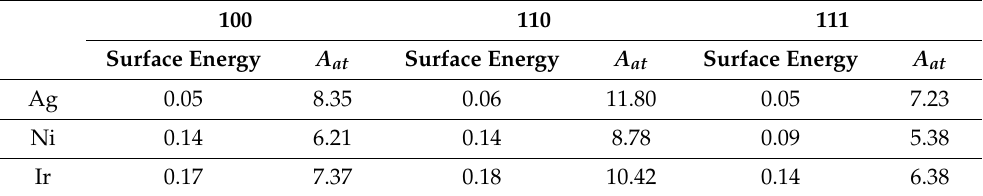
Table 1. The surface energies (eV/Å 2 ) and the surface area per atom A at (Å 2 ) of the three metals. 100 110 111 Surface Energy A at Surface Energy A at Surface Energy A at Ag